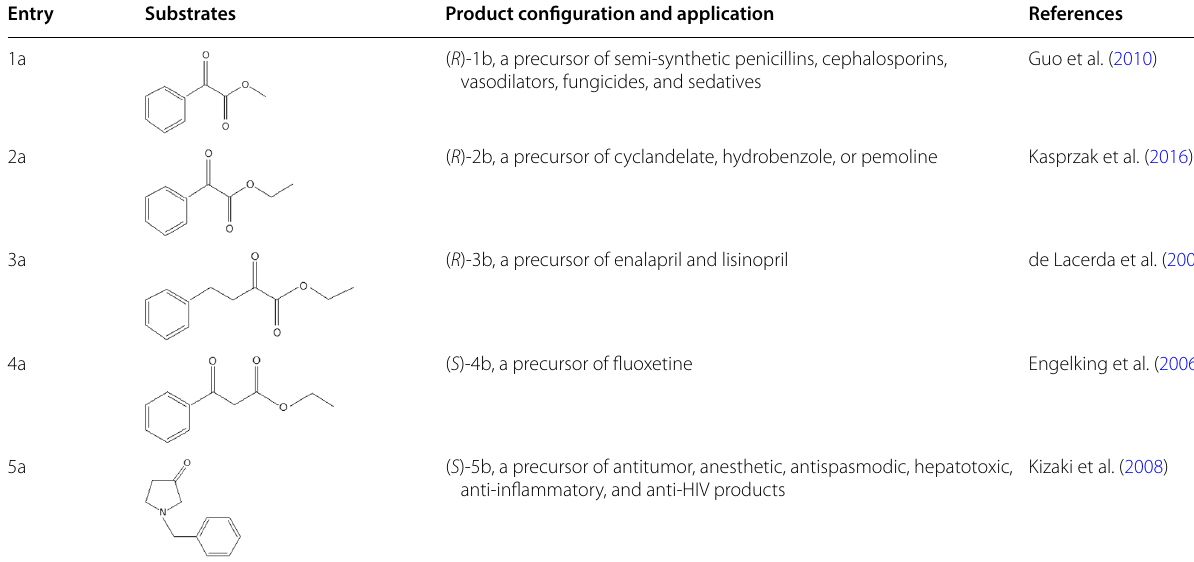
Table 1 Substrates and applications of the corresponding